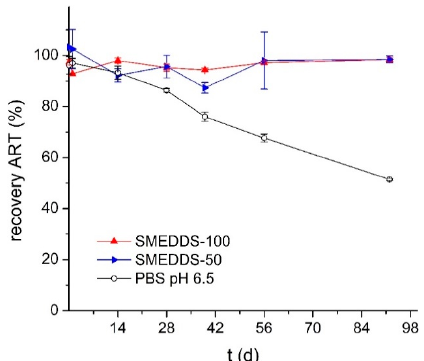
Figure 5. Stability of artemisone in SMEDDS-100, SMEDDS-50 and PBS pH 6.5 (pH equivalent to that